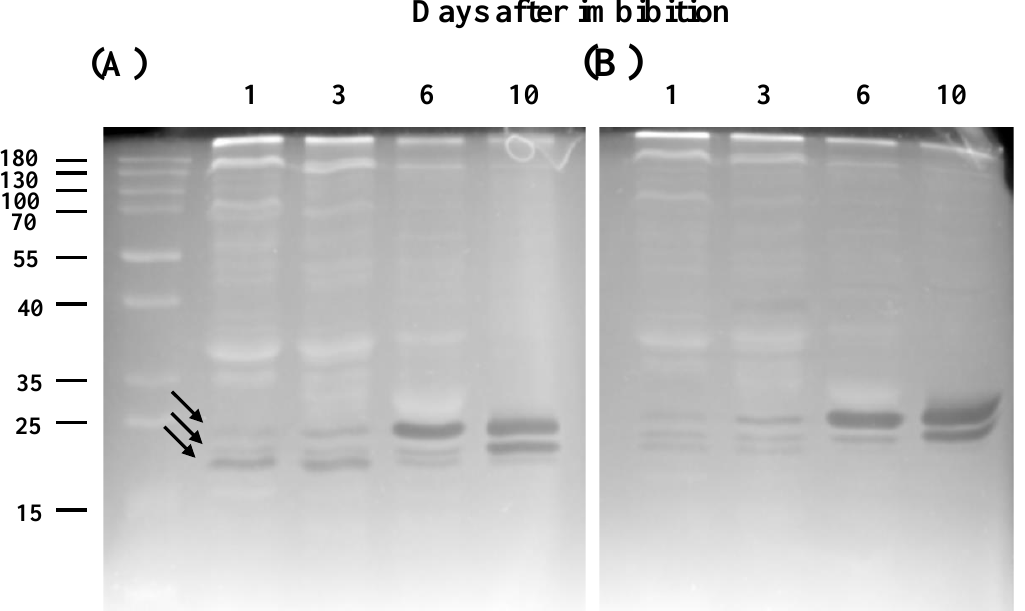
Figure 3. In-gel ribonuclease activity in common bean during cotyledon development. Ribonuclease activity was determined in acetate buffer pH 5.5 ( A ) and Tris buffer pH 7 ( B ) using crude extracts obtained from cotyledons at the indicated DAI. Equal amounts of crude extracts were loaded per lane. The mobility of molecular mass markers is shown on the left. After enzymatic assays, the gels were photographed and the images inverted. The main detected ribonucleases are marked with black arrows.